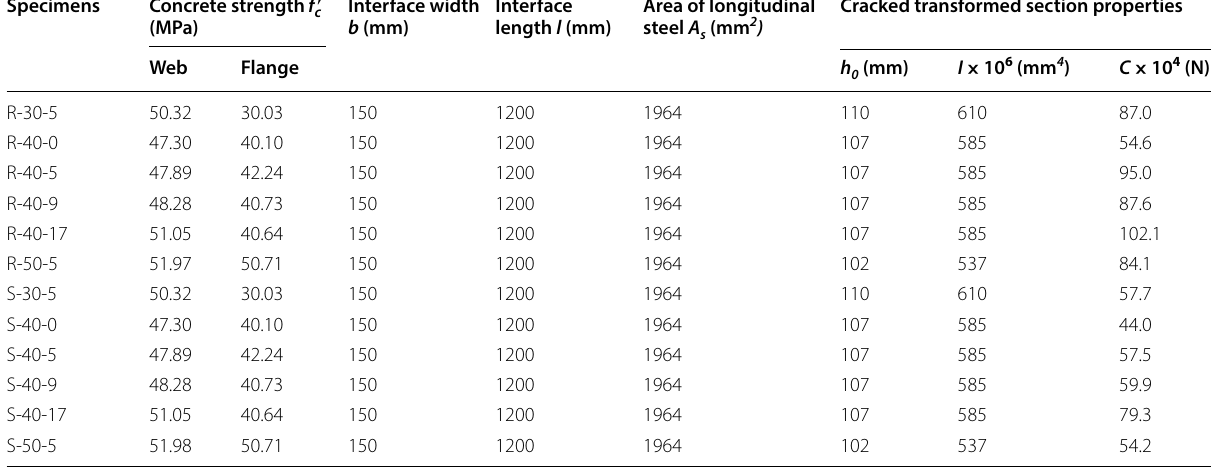
Table 5 Physical properties of test